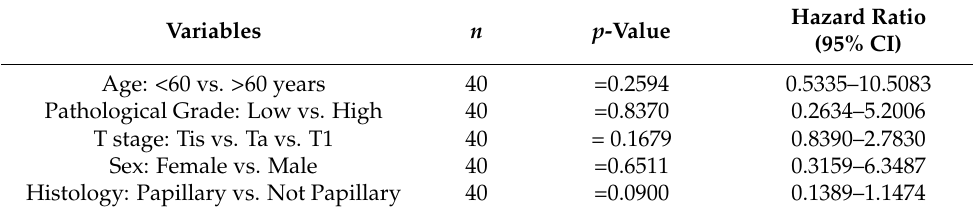
Table 7. Univariate analysisof clinicopathological characteristics affecting RFS in NMIB